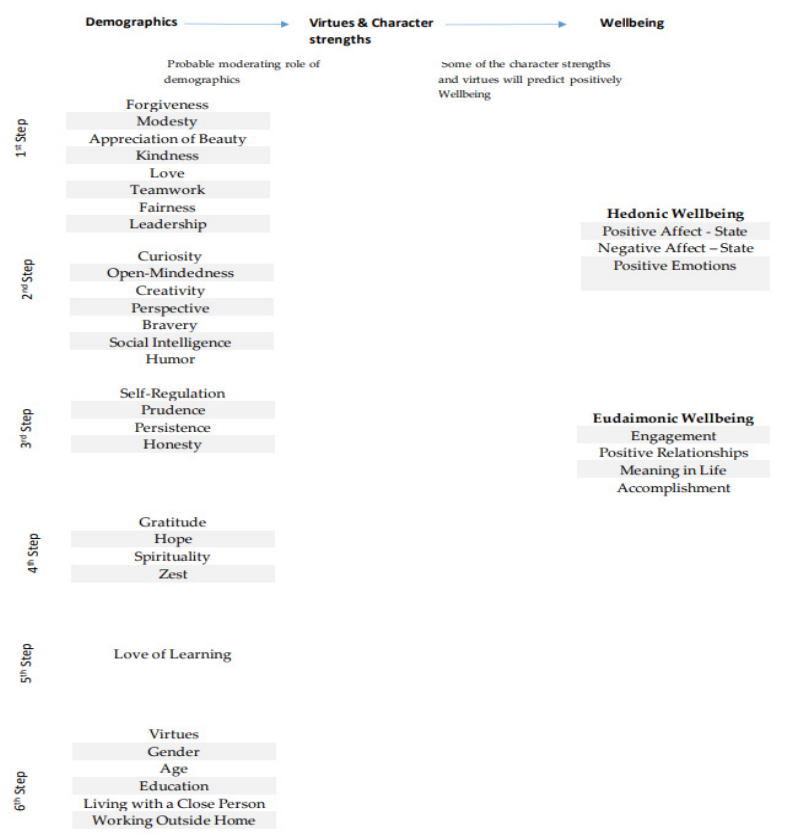
Figure 1. Research